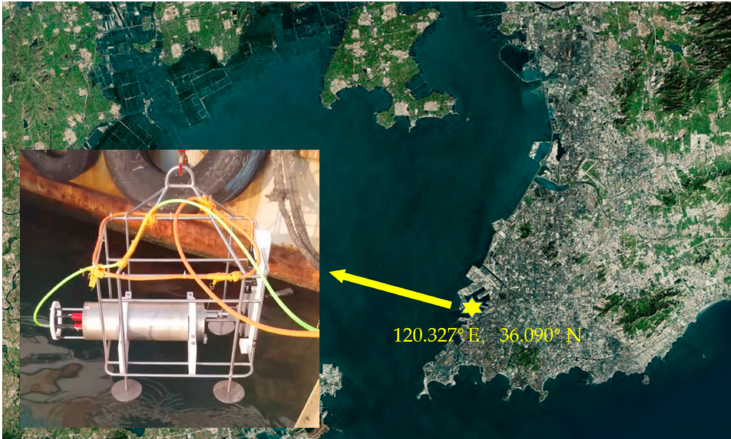
Figure 3. Map showing the location of nearshore underwater measurement in the Jiaozhou Bay.